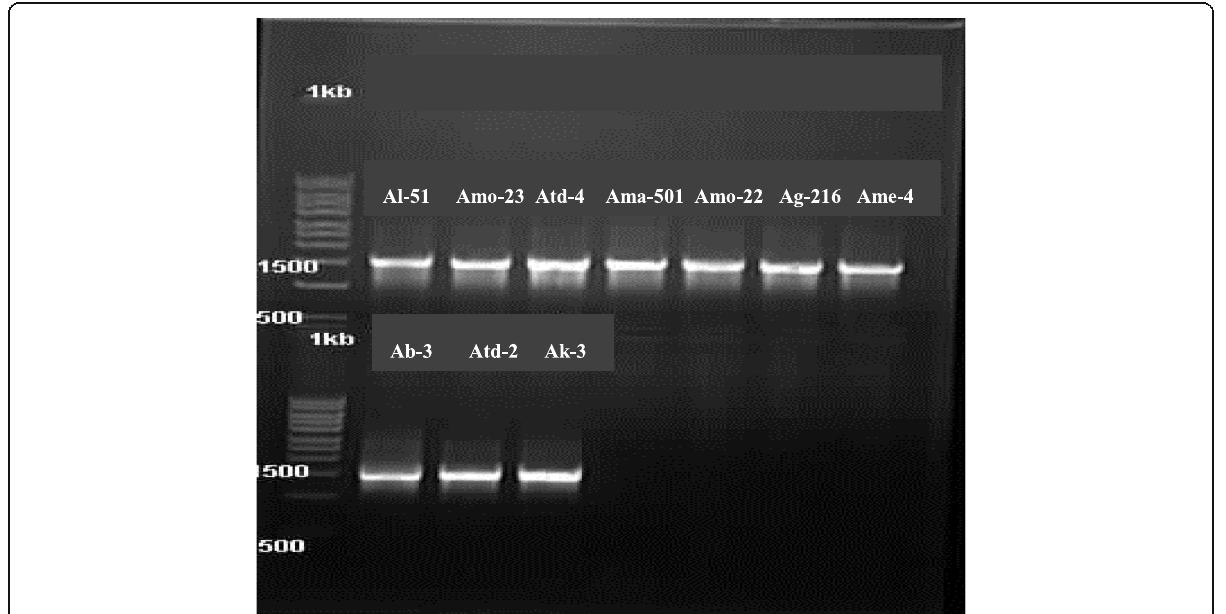
Fig. 5 Agarose gel showing the quality of DNA extracted from the 10 antagonist